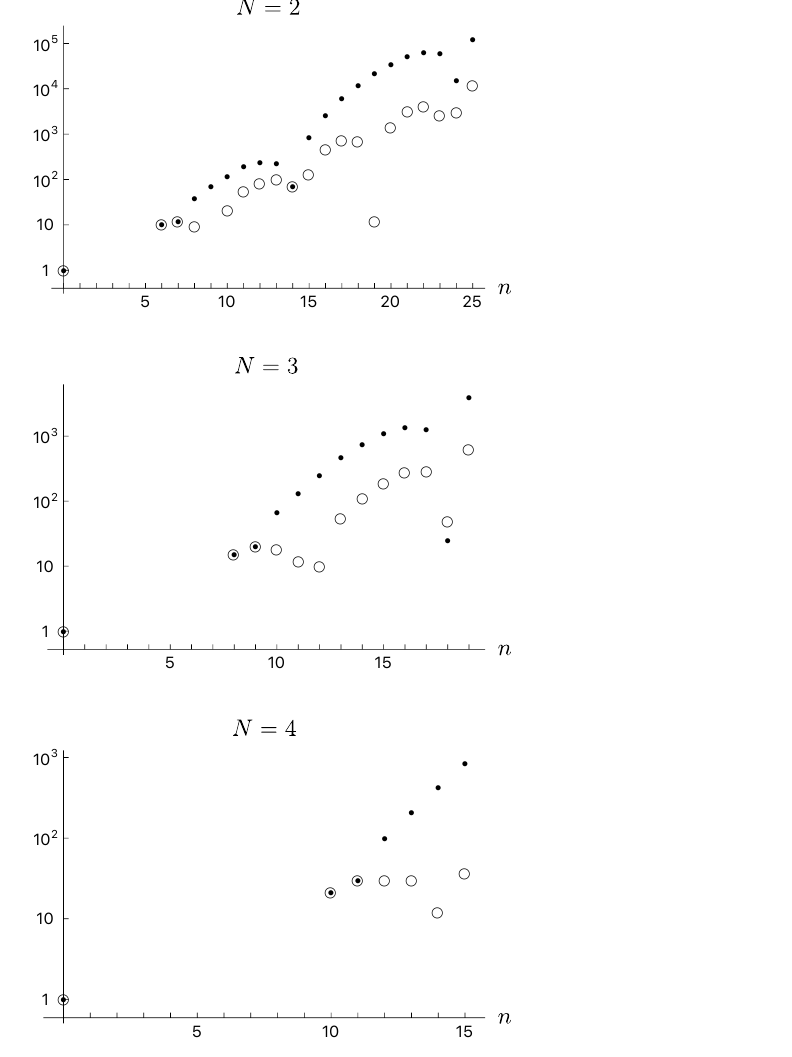
Figure 2 . Logarithmic plot of the absolute-valued coefficients of Z N /Z N = ∞ (dots) and I N /I N = ∞ (circles), for N = 2 , 3 , 4 .